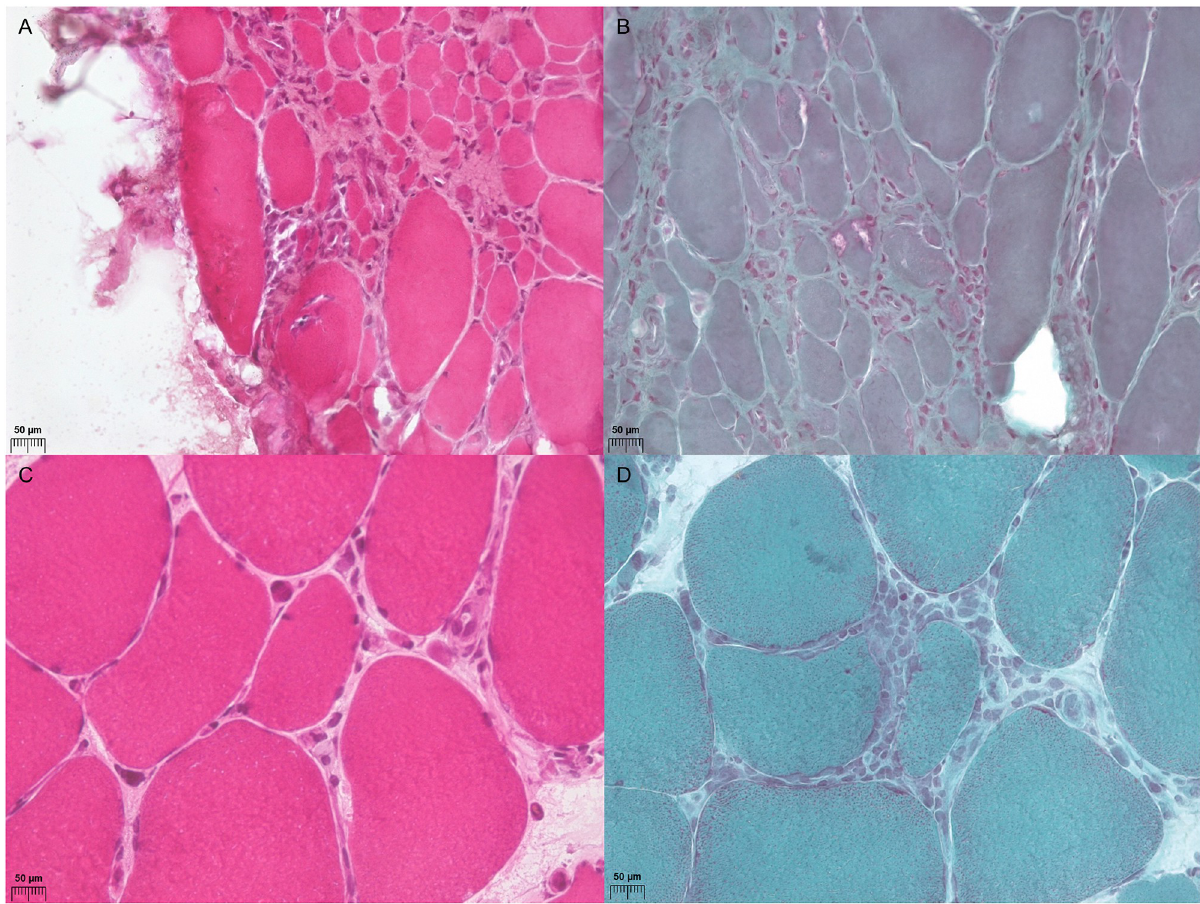
Fig 2. Pathology findings in patients with anti-NT5c1A antibody seropositive IBM: P4 (A and B) and P5 (C and D). In patient P4, pronounced muscle fiber size variation with atrophic changes and internalized nuclei, endomysial inflammatory infiltrates, and rimmed vacuoles. (A, hematoxylin and eosin [H&E] stain, B, modified Gomori trichrome [GT] stain, Magnification: x400). In patient P5, variable sizes of muscle fibers with endomysial inflammatory infiltrate without any partial muscle fiber invasion. (C, H&E stain, D, modified GT stain, Magnification: x400).